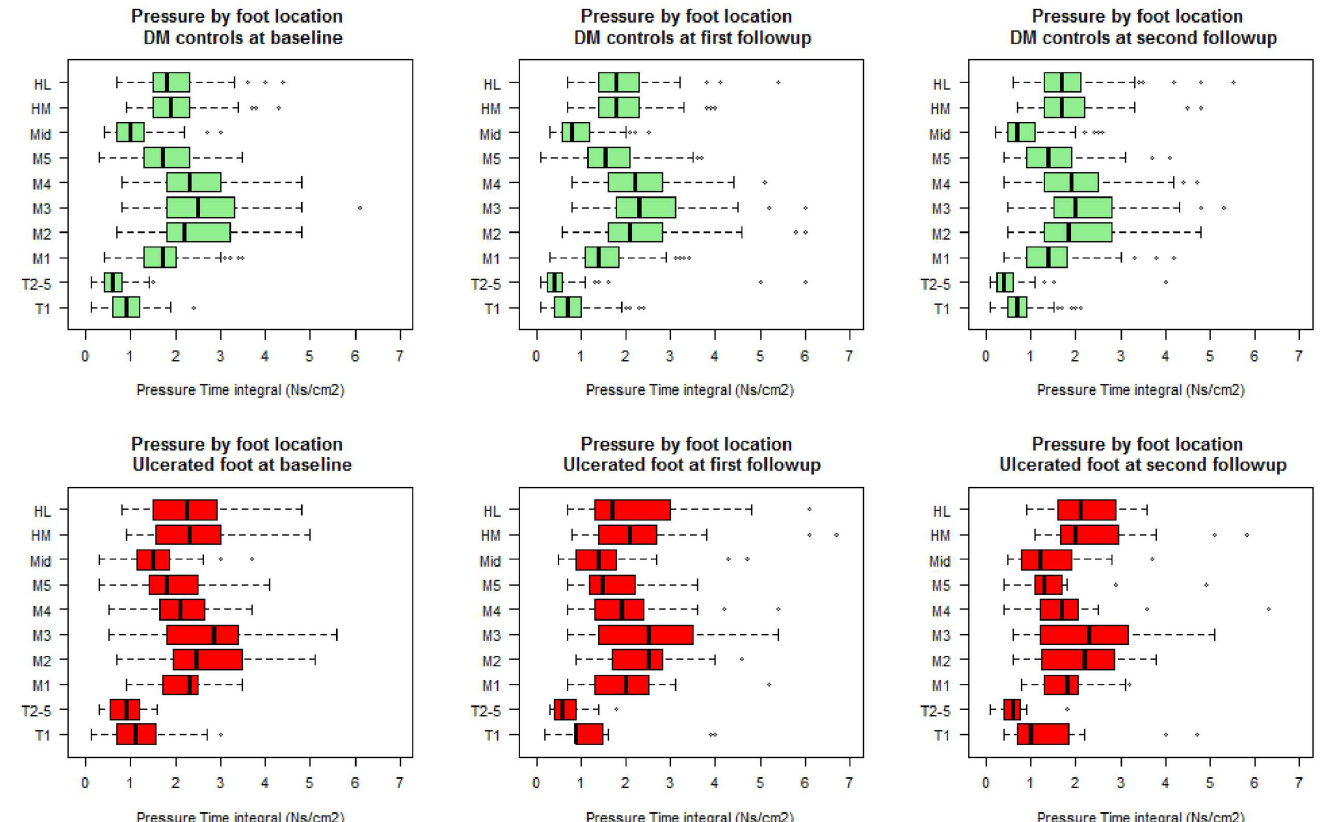
Fig 2. Site-specific pressure-time integrals over time in participants with DFUs and participants without DFUs. Figure indicates the pressure- time integralat ten plantar sites in cases (red) and diabetescontrols (DM controls) (green) at each visit. The x-axis has been scaled to allow for better data visualisation. All values are in Ns/Cm 2 and are reportedfor 10 plantar foot sites. T1 = hallux(big-toe), T2-5 = toes two to five, M1 = metatarsal one, M2 = metatarsal two, M3 = metatarsal three, M4 = metatarsal four, M5 = metatarsal five, Mid = mid-foot, HM = medialheel and HL = lateral